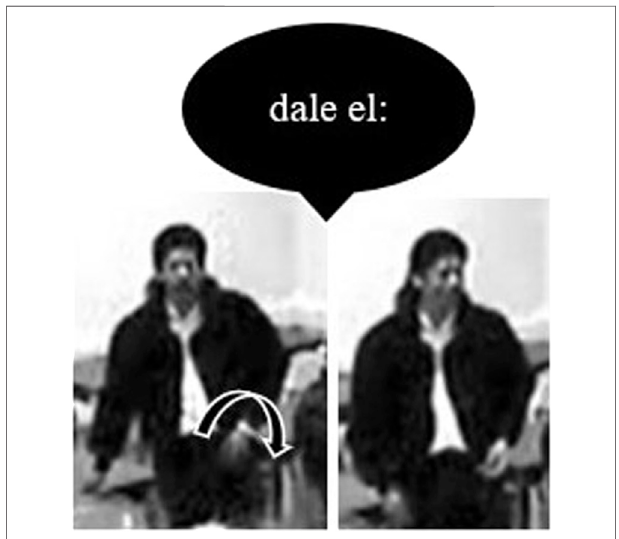
FIGURE 10 | Extract 5. line